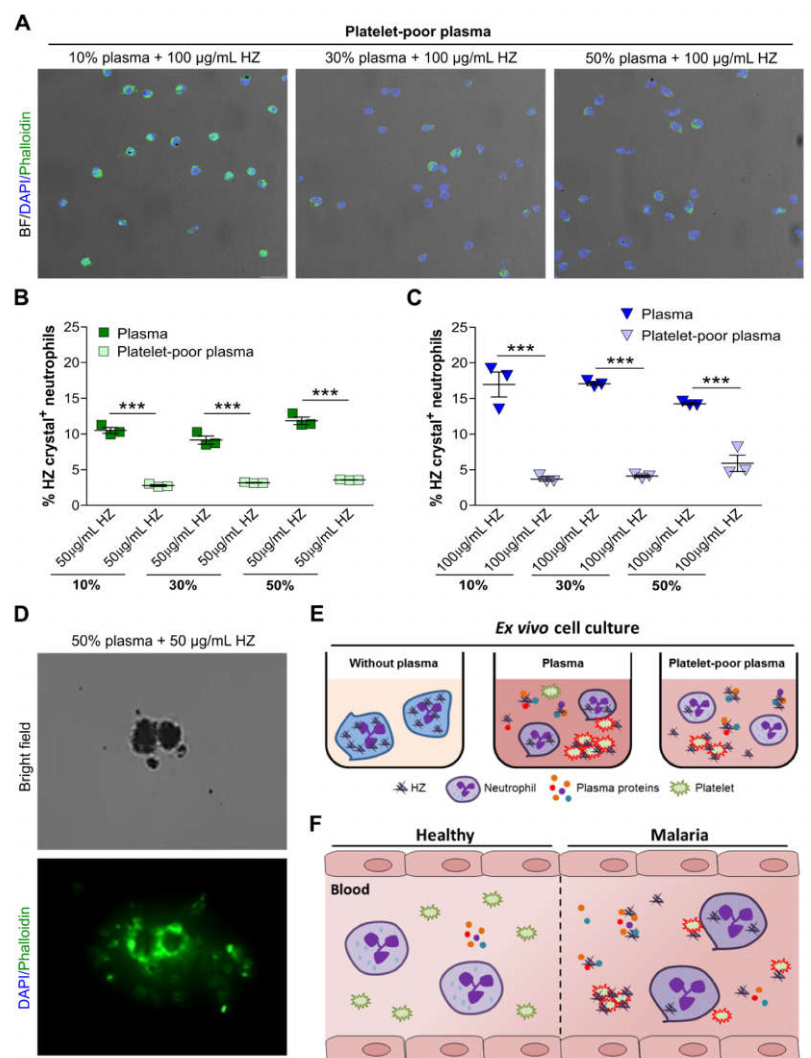
Figure 5. Platelet-poor plasma impaired hemozoin uptake by neutrophils. Human blood neutrophils were isolated from healthy volunteers and cultured with 10%, 30%, or 50% of platelet-poor plasma or plasma in the presence of HZ (50 and 100 µ g / mL) for 2 h, and fluorescence microscopy or flow cytometry was performed. ( A ) Neutrophils cultured in platelet-poor plasma with HZ were stained with phalloidin (green) and DAPI (blue) for fluorescence microscopy. Images are shown as a merge of phalloidin and DAPI with bright field (BF) (200 × magnification). ( B , C ) The percentage of neutrophils that had internalized HZ at concentrations of 50 µ g / mL ( B ) and 100 µ g / mL ( C ) in the presence of platelet-poor plasma or plasma were determined by flow cytometry ( n = 3 donors). ( D ) Human plasma containing platelets was incubated with 50 µ g / mL HZ and stained for phalloidin (green) for fluorescence microscopy (630 × magnification). Data are mean ± SD and representative of two independent experiments. *** p < 0.001; ns, not significant using two-way ANOVA. ( E ) Schematic of ex vivo neutrophil culture experiments with plasma or platelet-poor plasma in the presence of HZ. ( F ) Schematic illustrating that during malaria HZ crystals bind to plasma proteins, which was associated with a diminished endocytotic capacity of neutrophils. Despite the impaired HZ uptake, those few neutrophils that did ingest HZ crystals relied on HZ-induced platelet